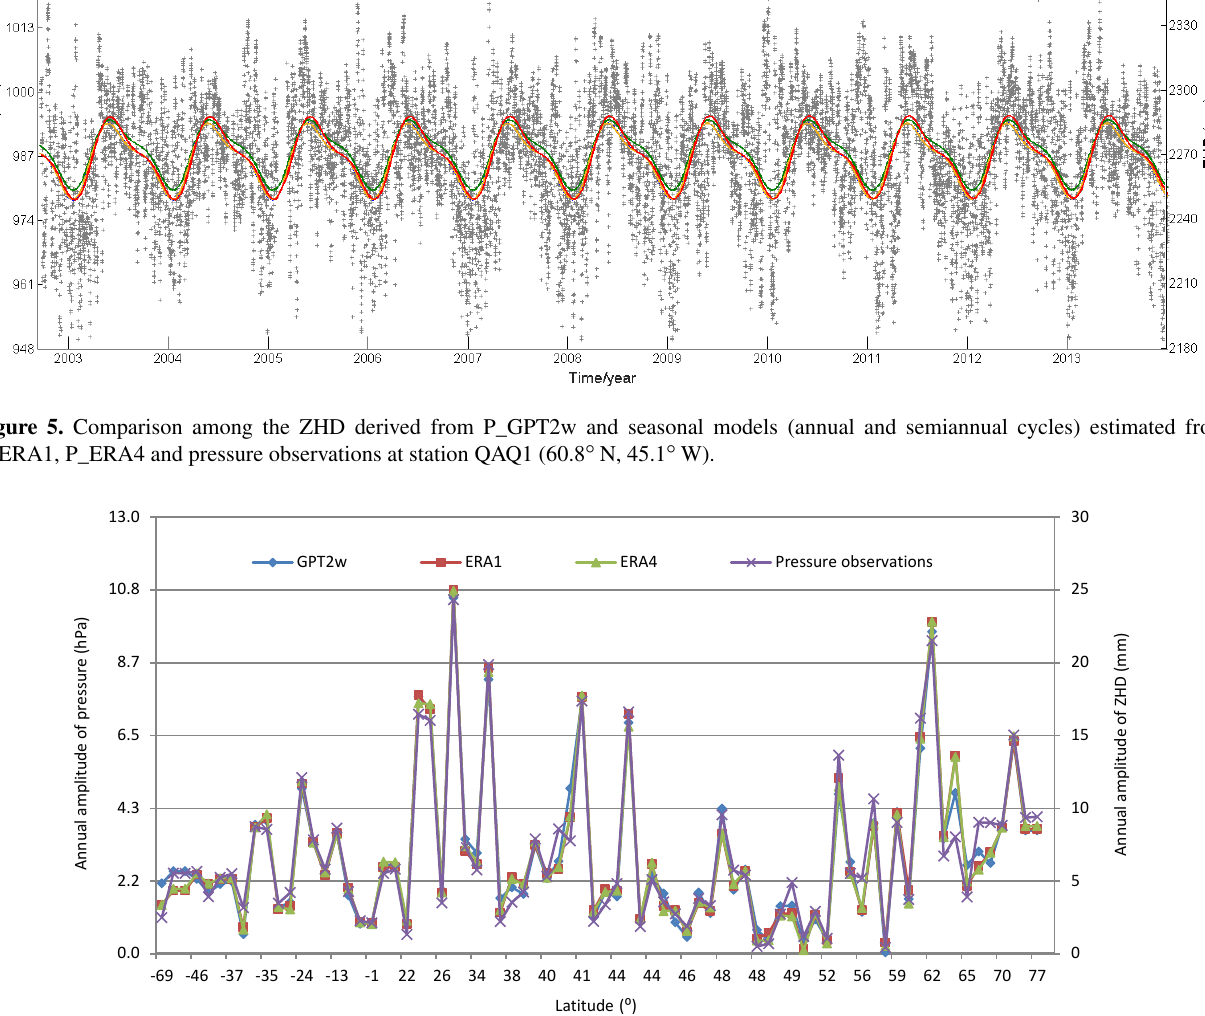
large errors are found in the GPT2w-derived IWV at low IWV values (Fig. 4) in mid- and high-latitude belts since